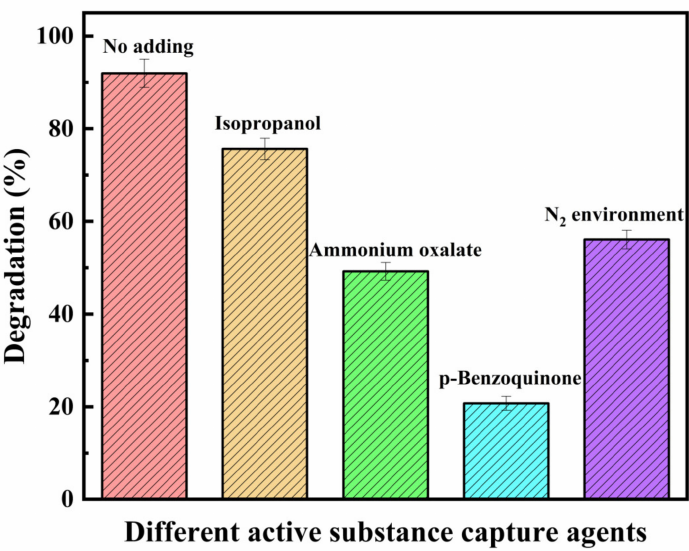
Figure 7. Effects of different scavengers on the AO 7 degradation for (Cu:Mg = 1:2) CuFe 2 O 4 /MgFe 2 O 4 (catalyst 0.8 g/L, AO 7 = 0.10 mM, scavenger 0.1